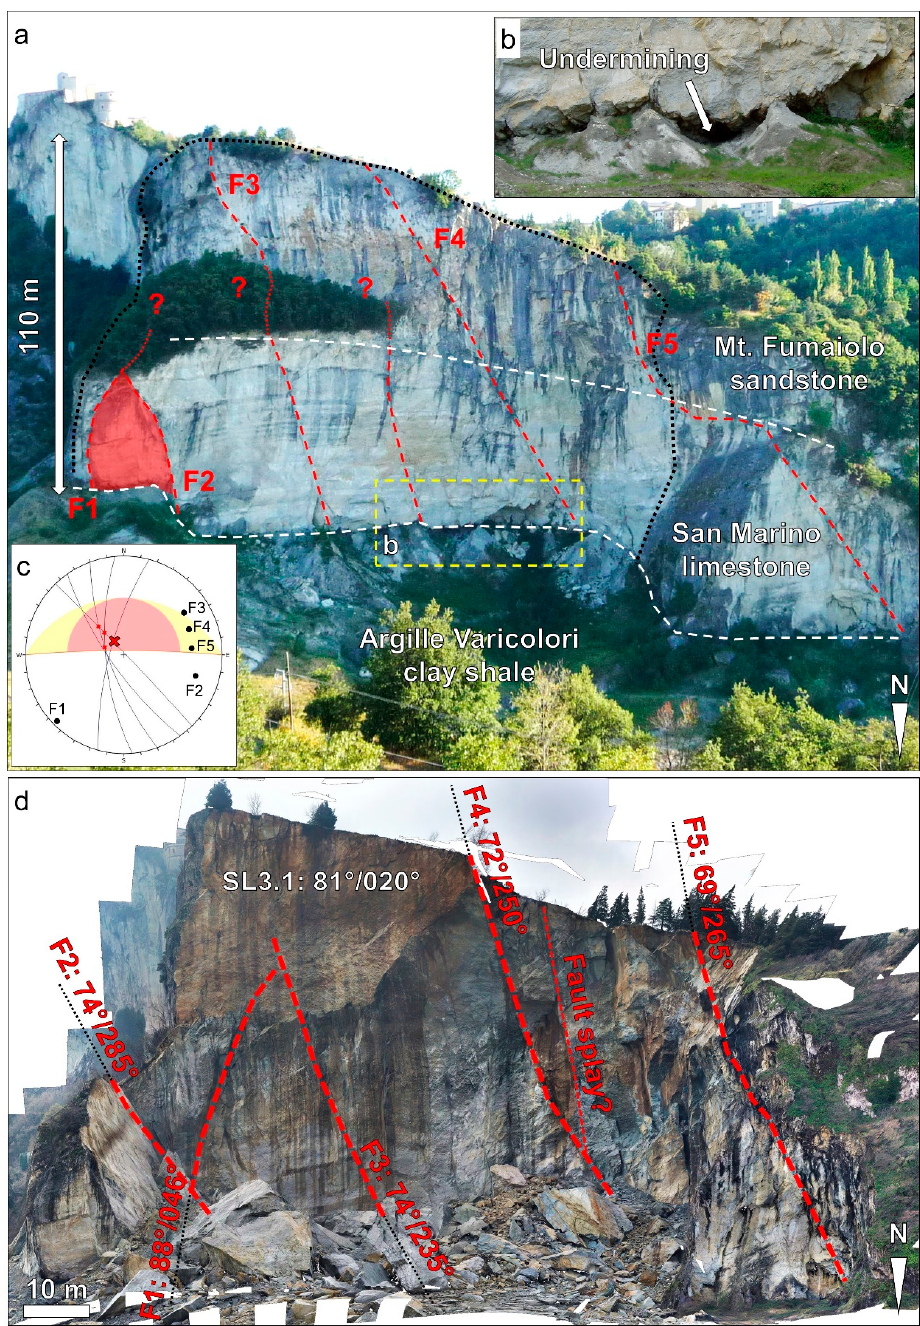
Figure 2. View of the investigated rock slope before and after the 2014 event. ( a ) Overview of the 110 m high slope before the failure. Red, dashed lines highlight the faults that cross the San Leo plateau. Note the wedge formed by the intersection of first-order geological structures F1 and F2. The white, dashed line indicates the contact between the Argille Varicolori and San Marino formations. Black, dotted line outlines the volume failed in 2014; ( b ) Detail of the undermining at the base of the plateau, due to remolding and erosion of clay shale; ( c ) Kinematic wedge failure analysis. The large, red cross highlights the intersection forming Wedge F1–F2; ( d ) Structural interpretation of the rock slope after the 2014 event. Red, dashed lines identify first-order faults; note the subvertical, oxidized surface of discontinuity SL3.1 (photographs a and b are courtesy of C. Guerra).